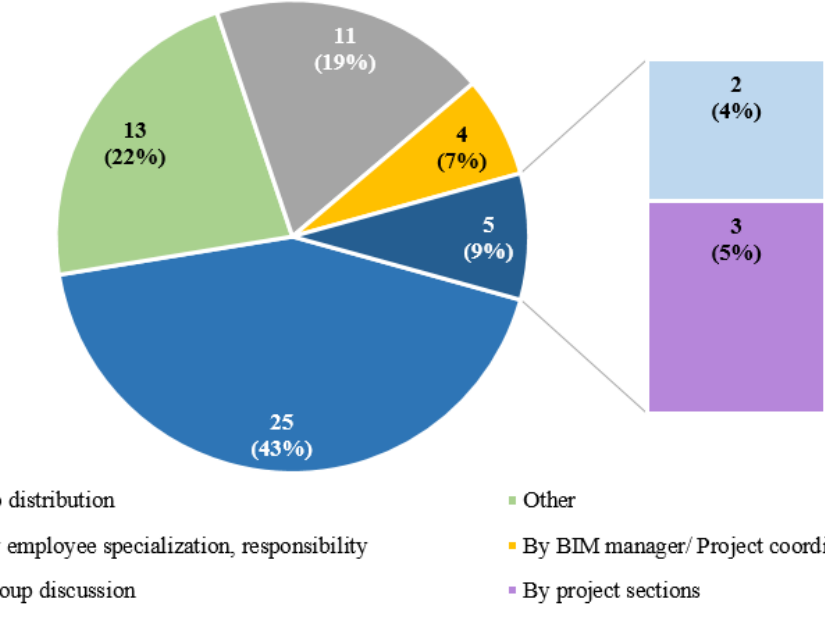
Figure 8. Distribution of work on collisions among team members.